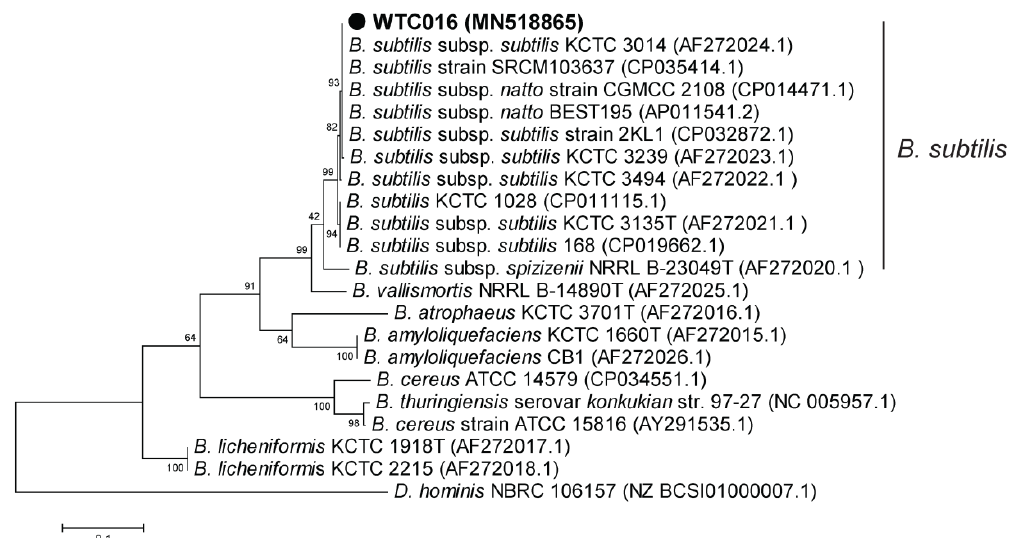
Figure 4. Phylogenetic tree based on the partial gyrA of WTC016 and other homologous Bacillus strains. The phylogenetic tree was constructed using the maximum likelihood method by MEGA5 [32]. The Gen-Bank accession numbers of all the sequences are indicated in parentheses. The bar represents 0.01 substitutions per site. Dermabacter hominis ( D. hominis ) strain NCFB 2769 was used as the outgroup.